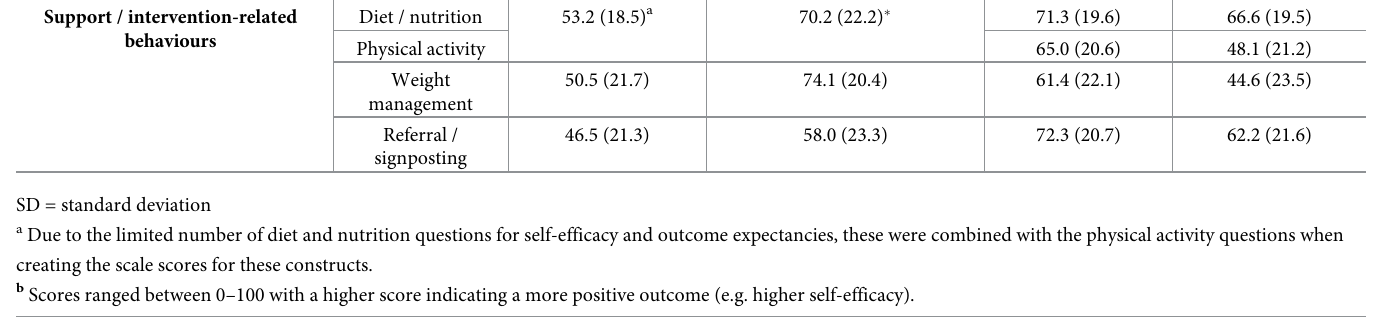
efficacy and outcome expectancies were the key barriers to communication-related behav- iours, and that self-efficacy was the key barrier to support/intervention-related behaviours. The majority of barriers to practice identified in the models related to the support/interven- tion-related behaviours, which is also reflected in these baseline data which overall were lowest scoring. The pre-intervention mean BAOP scores were low (14.6, SD 5.7) reflecting a tendency towards beliefs that obesity is within the individual’s control. Comparing intervention and control arms. The descriptive statistics for pre- and post- intervention data are shown in Table 3, split by the communication- and support/interven- tion-related categories. The mean scores for the communication-related category were higher overall than for the support/intervention-related category. Communication-related behaviours